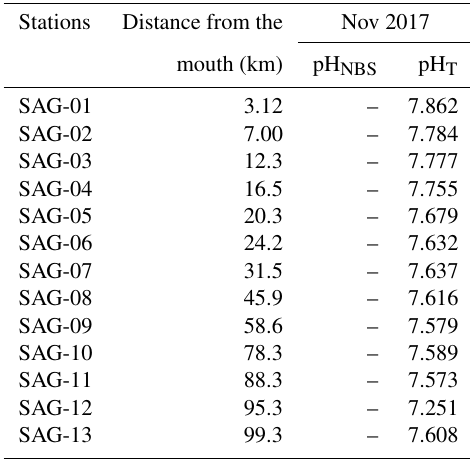
Table B2. Raw in situ pH data for surface waters collected in November 2017. pH was only reported on the total scale during this cruise, where 1.4< S P